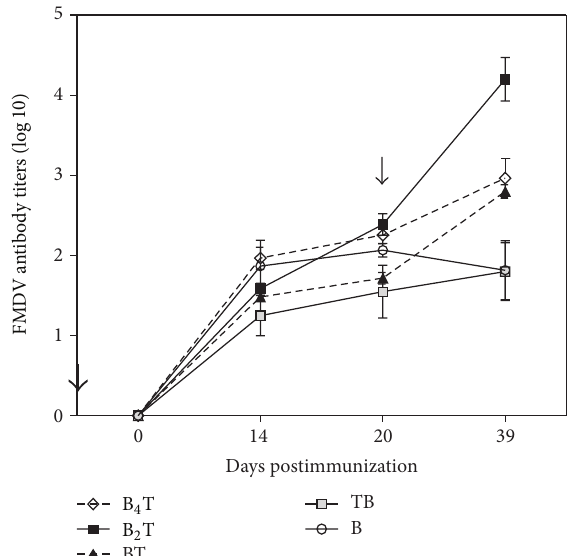
Figure 1: Time course study of antibody responses to FMDV in sera analyzed by ELISA. Specific antibody titers against FMDV (O UKG 11/2001) measured by ELISA in serum samples collected at days 0, 14, 20, and 39 postimmunization. Antibody titers were expressed as the reciprocal log 10 of the last dilution calculated by interpolation to give an absorbance of 1 above background. Each point corresponds to the geometric mean of a least two determinations. In all cases the standard deviation was < 1.0. Arrows indicate immunization (first dose and boost) dates.